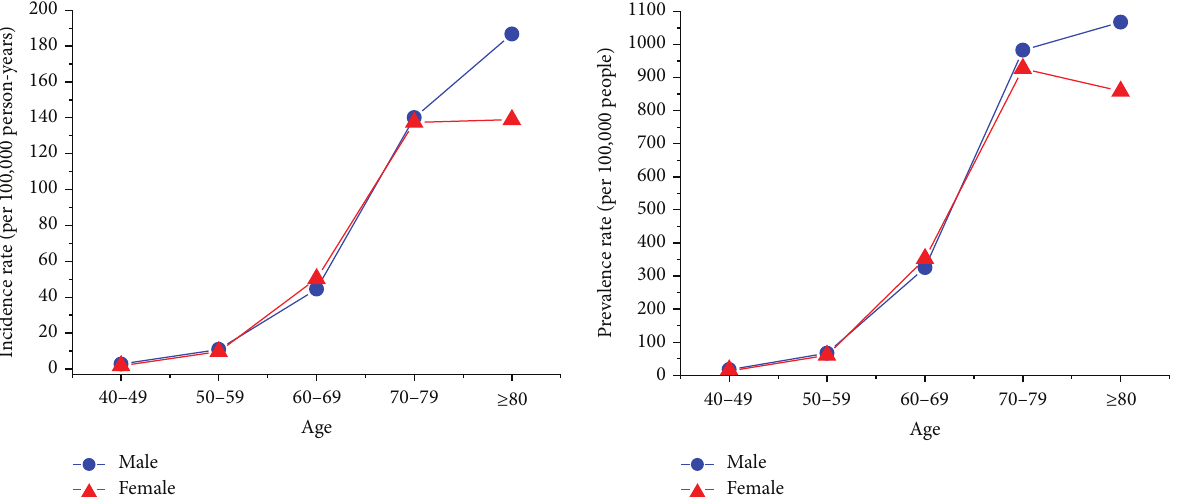
Figure 2: Age- and sex-specific incidence and prevalence rates of Parkinson’s disease in Taiwan,